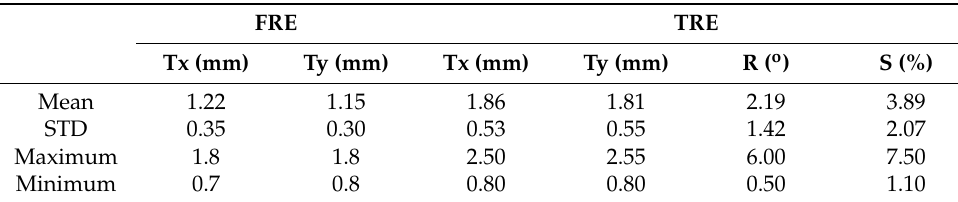
Table 1. Error measurements for ultrasound to fluorescence image registration using Aruco fidu- cial